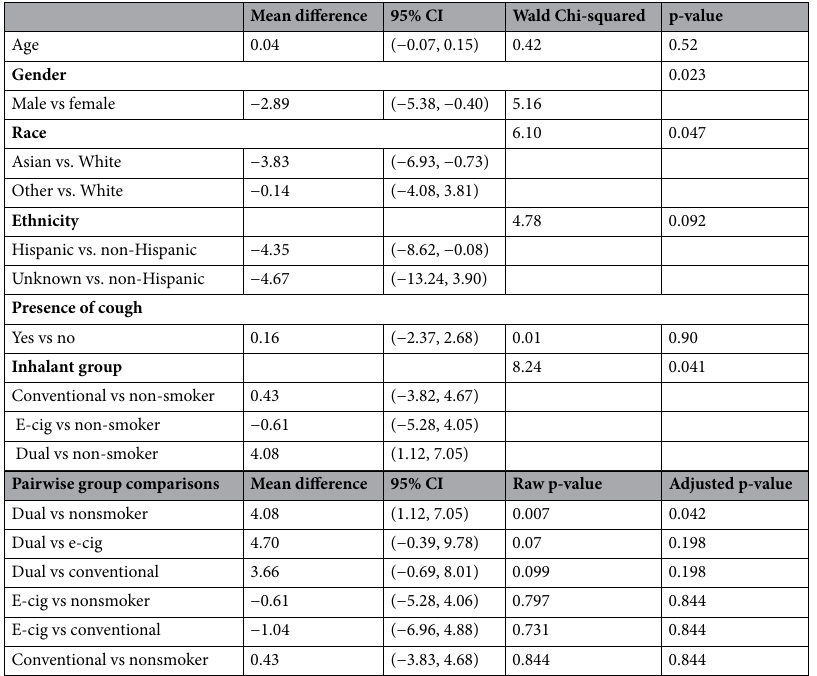
Table 2. Multivariable linear regression model to assess the association between inhalant groups and sleep latency by PSQI. This table shows the multivariable linear regression model with sleep latency as the outcome, inhalant groups, age, gender, race, ethnicity, and presence of cough as the predictors. The bottom table further shows the pairwise comparisons among inhalant groups with adjusted p-values using the method of Benjamini & Hochberg. Sleep latency was determined through the following open-ended question included within the Pittsburgh Sleep Quality Index (PSQI), “During the past month, how long (in minutes) has it taken you to fall asleep each